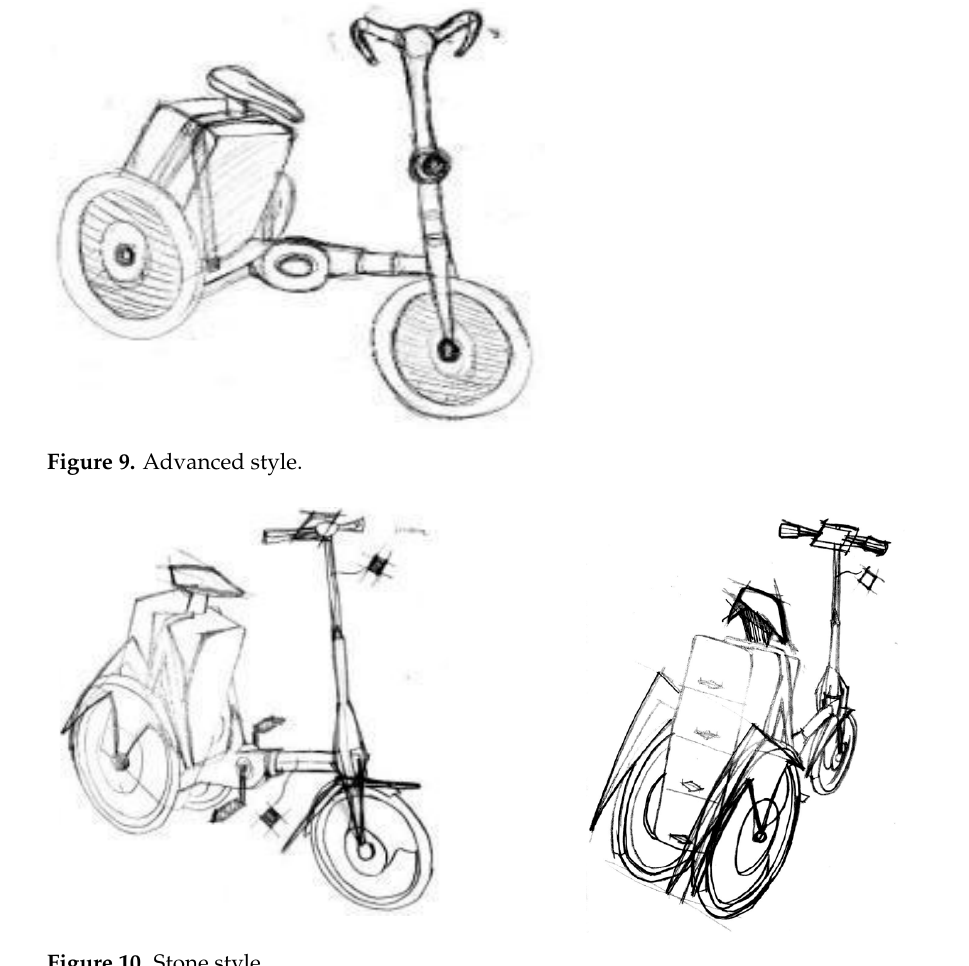
Figure 12. Stylistic references for the retro style—the Graziella Cinzia.